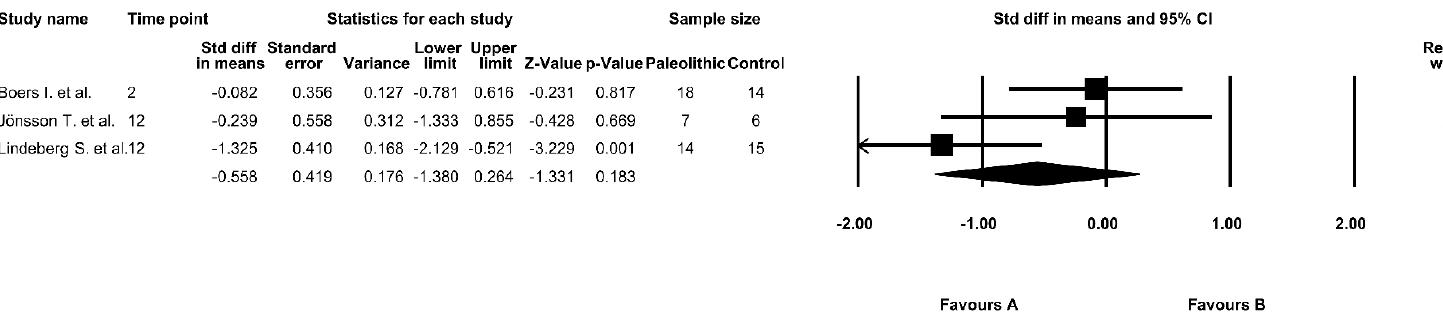
Figure 7. Forest plot comparing area under the curve (AUC) 0–120 glucose levels between the diets (favors A—Paleo group; favors B—control group).